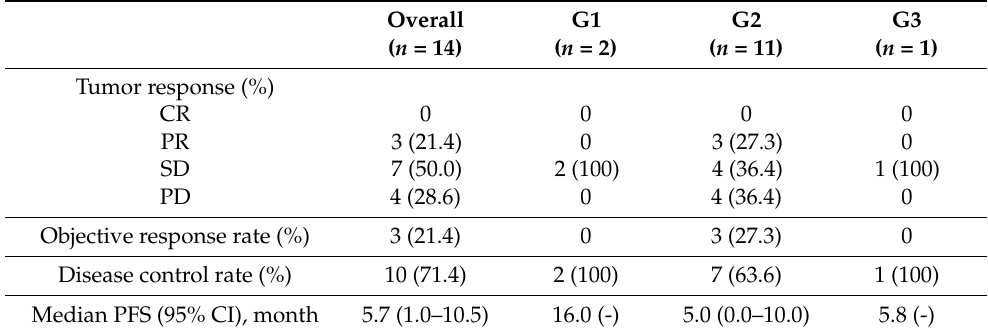
Figure 1. Progression-free survival with everolimus rechallenge. Kaplan–Meier curves for progression-free survival (PFS) with everolimus rechallenge. The median PFS with everolimus rechallenge was 5.7 (95% CI, 1.0–10.5) months. Table 2. Tumor response and progression-free survival with everolimus